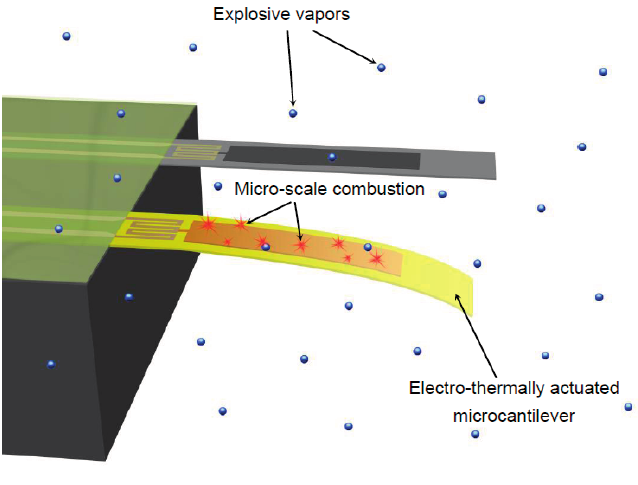
Figure 1. Schematic representation of the sensing mechanism proposed in this